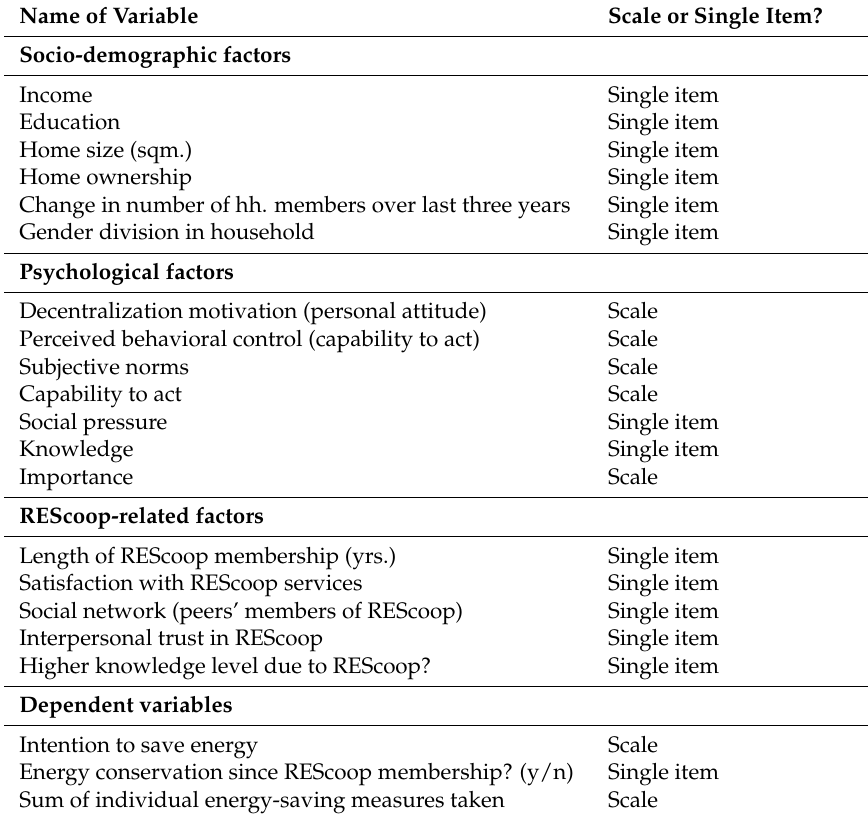
Figure 1. Graphical depiction of the research model. Table 2. Measurement of variables.